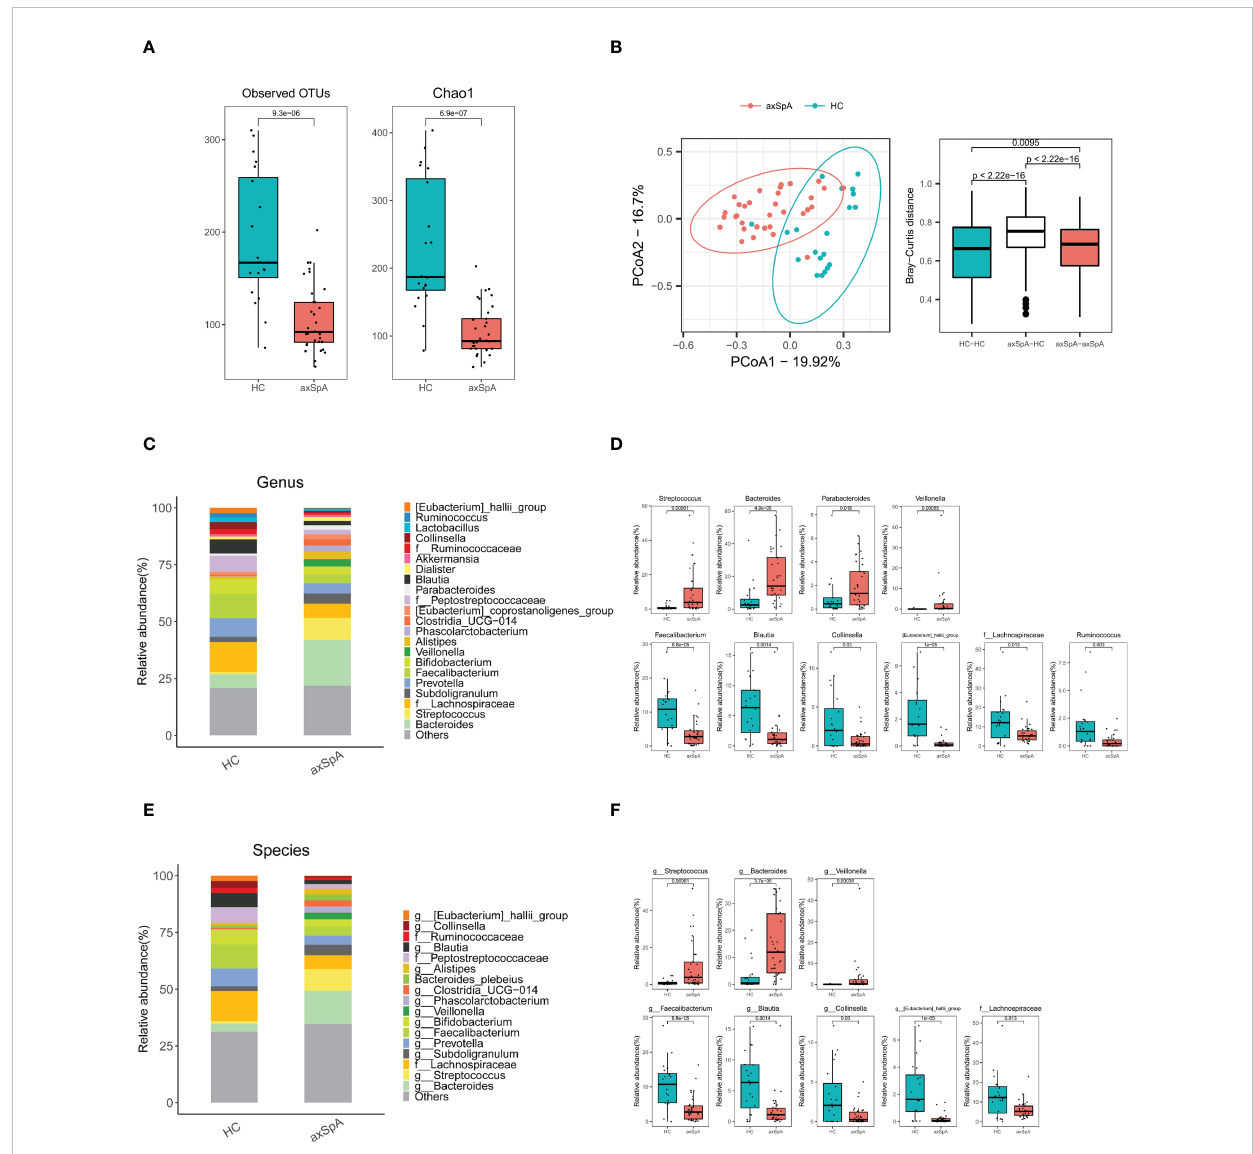
FIGURE 1 Comparison of gut microbiomes between axial spondyloarthritis (axSpA) patients and healthy controls (HCs). Feces were obtained from axSpA patients (N = 33) and HCs (N = 20), and 16s rRNA was analyzed using next generation sequencing. (A) a -diversity measured by observed OTUs and Chao1 score and (B) b -diversity using PCoA based on Bray-Curtis dissimilarity between axSpA patients (N = 33) and HCs (N = 20). Pearson ’ s correlation (r) and the corresponding P values are presented. Relative abundance of gut microbes in axSpA patients and HCs according to genus (C, D) , and species levels (E, F ). Species-level gut microbes that were signi fi cantly different between groups are presented. OTUs, operational taxonomic units; PCoA, principal coordinate